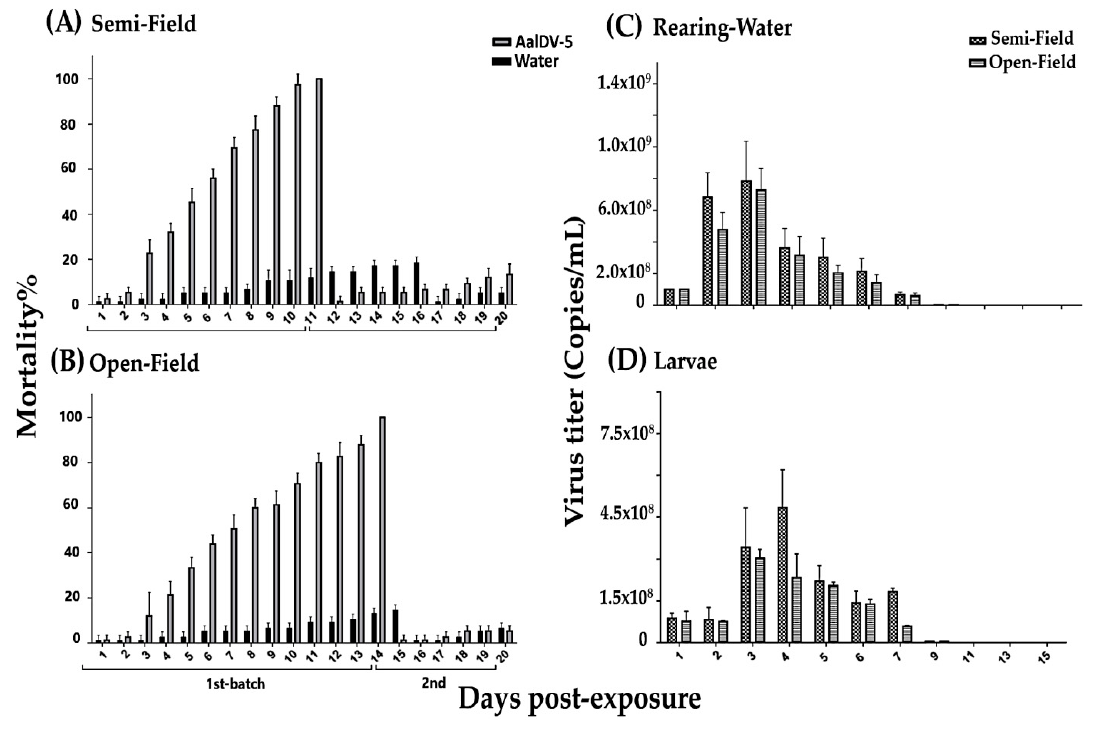
Figure 6. Bioassay of AalDV-5 against Ae. albopictus larvae. First instar larvae were treated with the AalDV-5 lab strain (1 × 10 8 copies/mL) in ( A ) semi-field and ( B ) open-field environments; furthermore, the mortality rate of mosquito larvae were recorded for 20 days post-exposure with 3 biological replicates. The error bars indicate SDs from three biological replicates ( n = 25 per replicate). ( C ) Virus quantification in larval rearing water and ( D ) larvae bodies in both semi-field and open-field conditions were evaluated (0–15 dpe), with the respective standard deviations from three biological replicates ( n = 25 per replicate). Table 1. The infection and pathogenicity of AalDV-5 on non-target